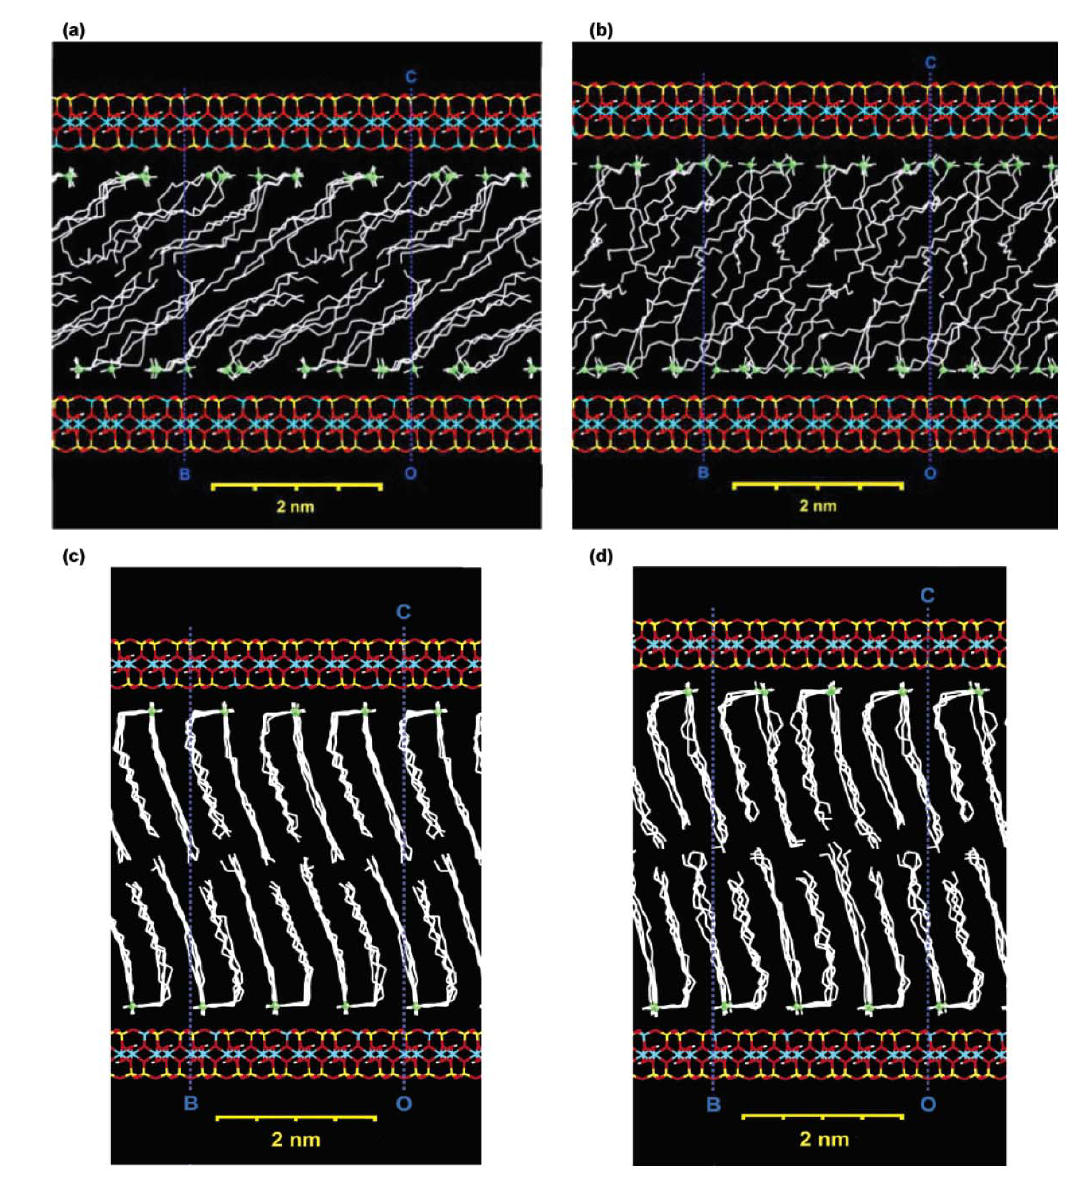
Figure 5. Snapshots of octadecyltrimethylammonium (C18) modified mica and dioctadecyldimethylammonium (2C18) modified mica in MD after 400 ps. (a) C18-mica, 20 °C; (b) C18-mica, 100 °C; (c) 2C18-mica, 20 °C; (d) 2C18-mica, 100 °C. A major conformational change (corresponding to two phase transitions) in C18-layered mica can be seen, whereas in 2C18-mica, only some more gauche-conformations are present